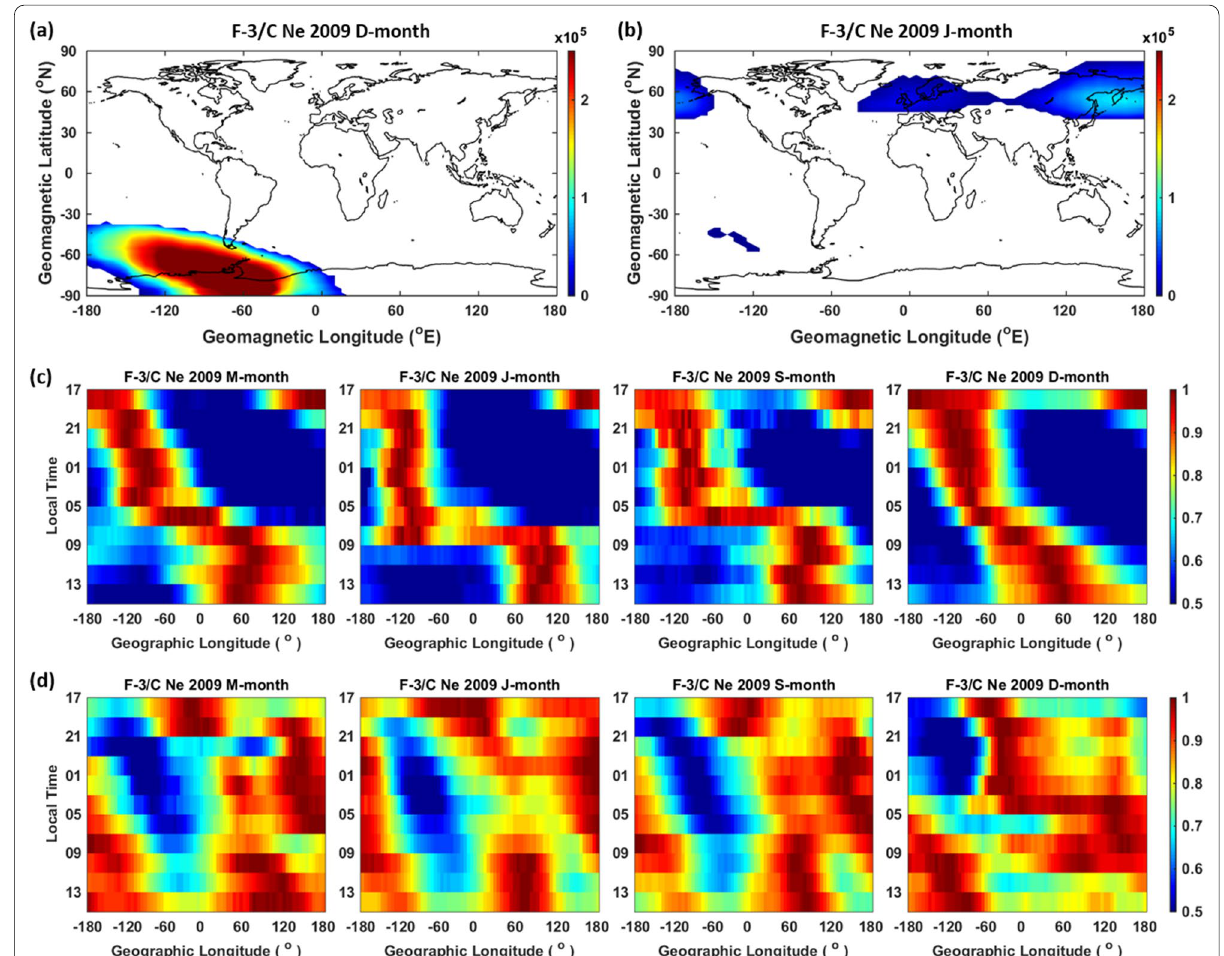
Fig. 6 Subtractions of the F‑3/C Ne at 300‑km altitude at 1300 LT from those at 2300 LT during a D‑month and b J‑month of 2009, respectively. The white regions are the subtracted F3/C Ne values being either outside of the WSA/OSA latitude zones or negative. Bottom panels are extracted from the 300‑km altitude Ne at c 60°S geographic and d 45°N geographic. The single‑peak in two segmented eastward phase shifts 167 and 296 m/s are computed by averaging three‑time‑point fitting shift by 1 point over the period of 1700–0300 LT and 0300–1700 LT, respectively. The double‑peak in two eastward phase shifts 91 and 121 m/s are computed by averaging three‑time‑point fitting shift by 1 point in 135° E–115° W and 50° W–100° E latitudinal zone,